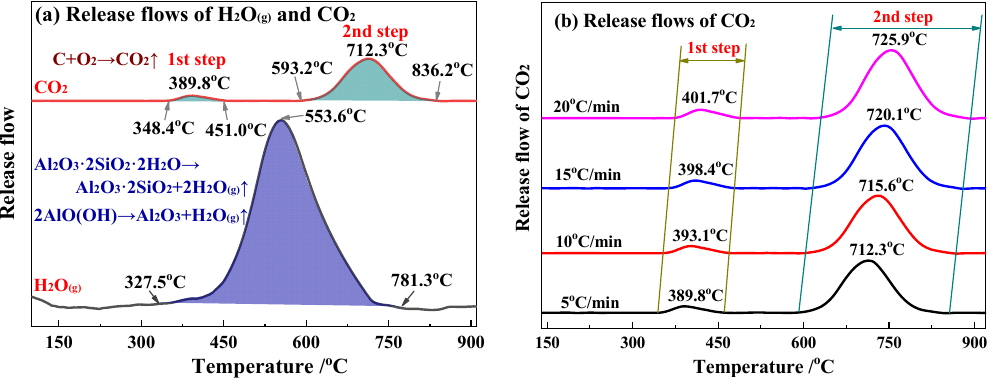
Figure 5. Release flow curve of gas products.